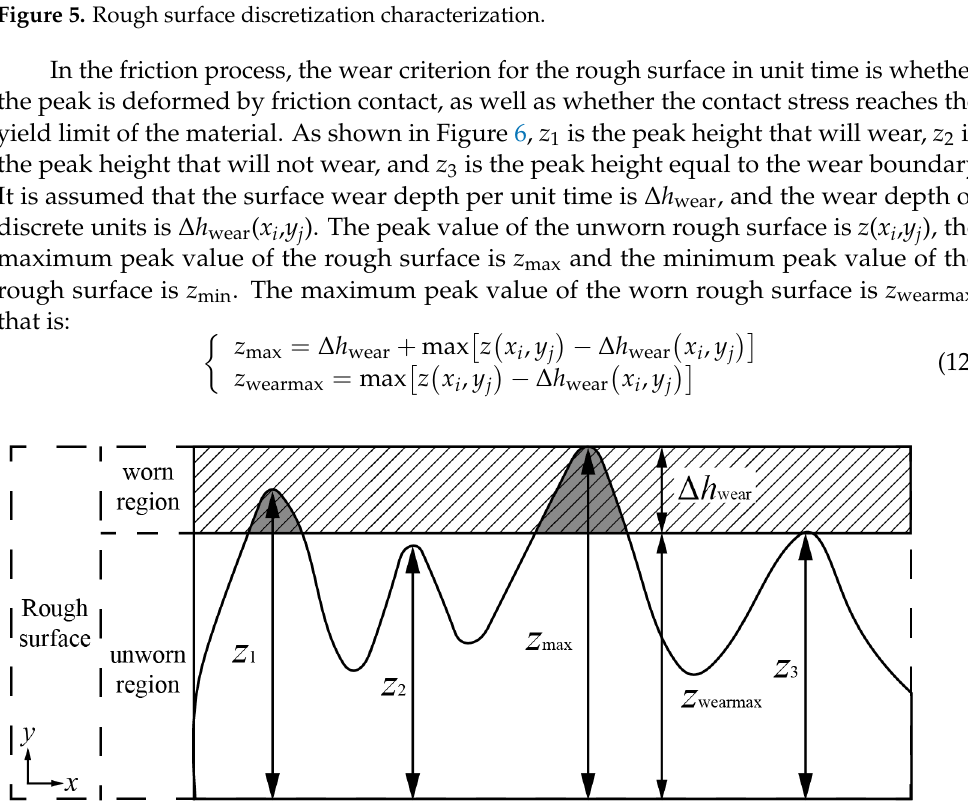
Figure 6. Surface topography changes of peaks during friction.